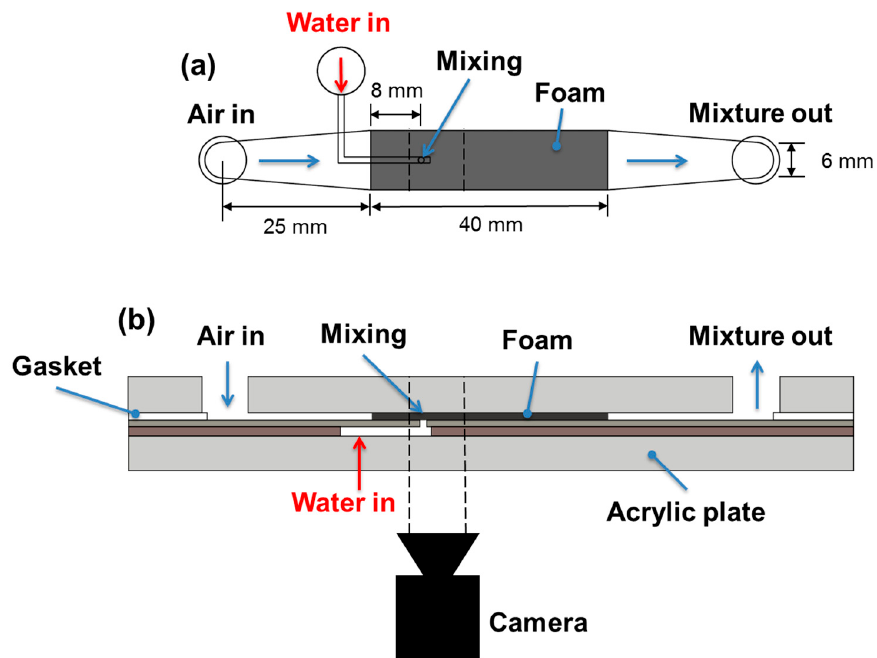
Figure 2. Ex-situ test fixture design ( a ) Top view, ( b ) Side section view through mixing